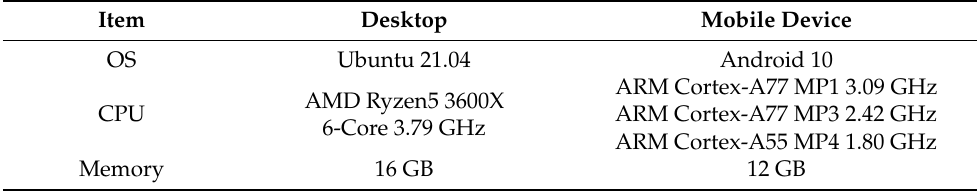
Table 3. Desktop and mobile device specifications for performance comparison of SLAM